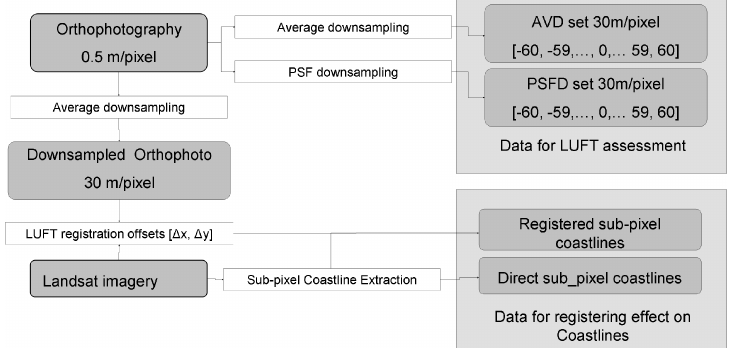
Figure 4. Workflow followed to create the images for the tests. The same orthophotography has been used both to create the images to test phase correlation LUFT and to serve as reference for Landsat imagery.